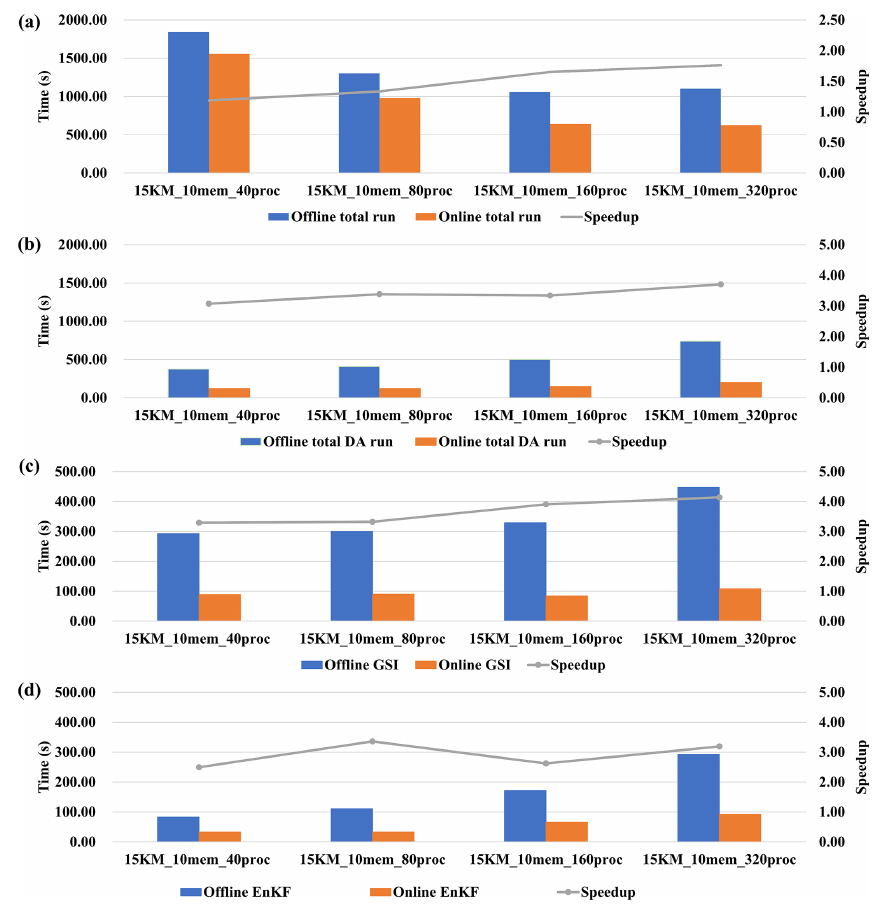
Figure 14. The same as in Fig. 13 but from experiment set 2 in Table